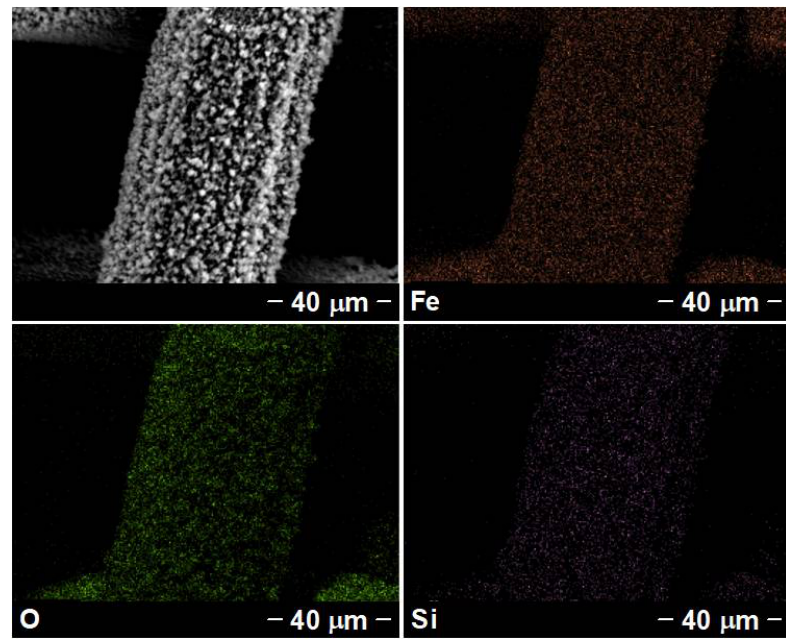
Figure 4. Images of OTS@Fe 2 O 3 -NCs@SSM on EDS elemental mappings.